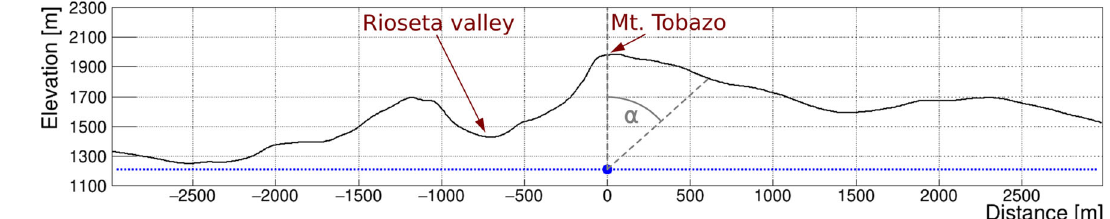
Fig. 1 Mountain profile along the path of the railroad tunnel. The distances are given from the Hall A of LAB2400, marked as a large dot at x = 0 m. The positive direction is towards France. The blue dotted line indicates the elevation of the floor level at the LSC